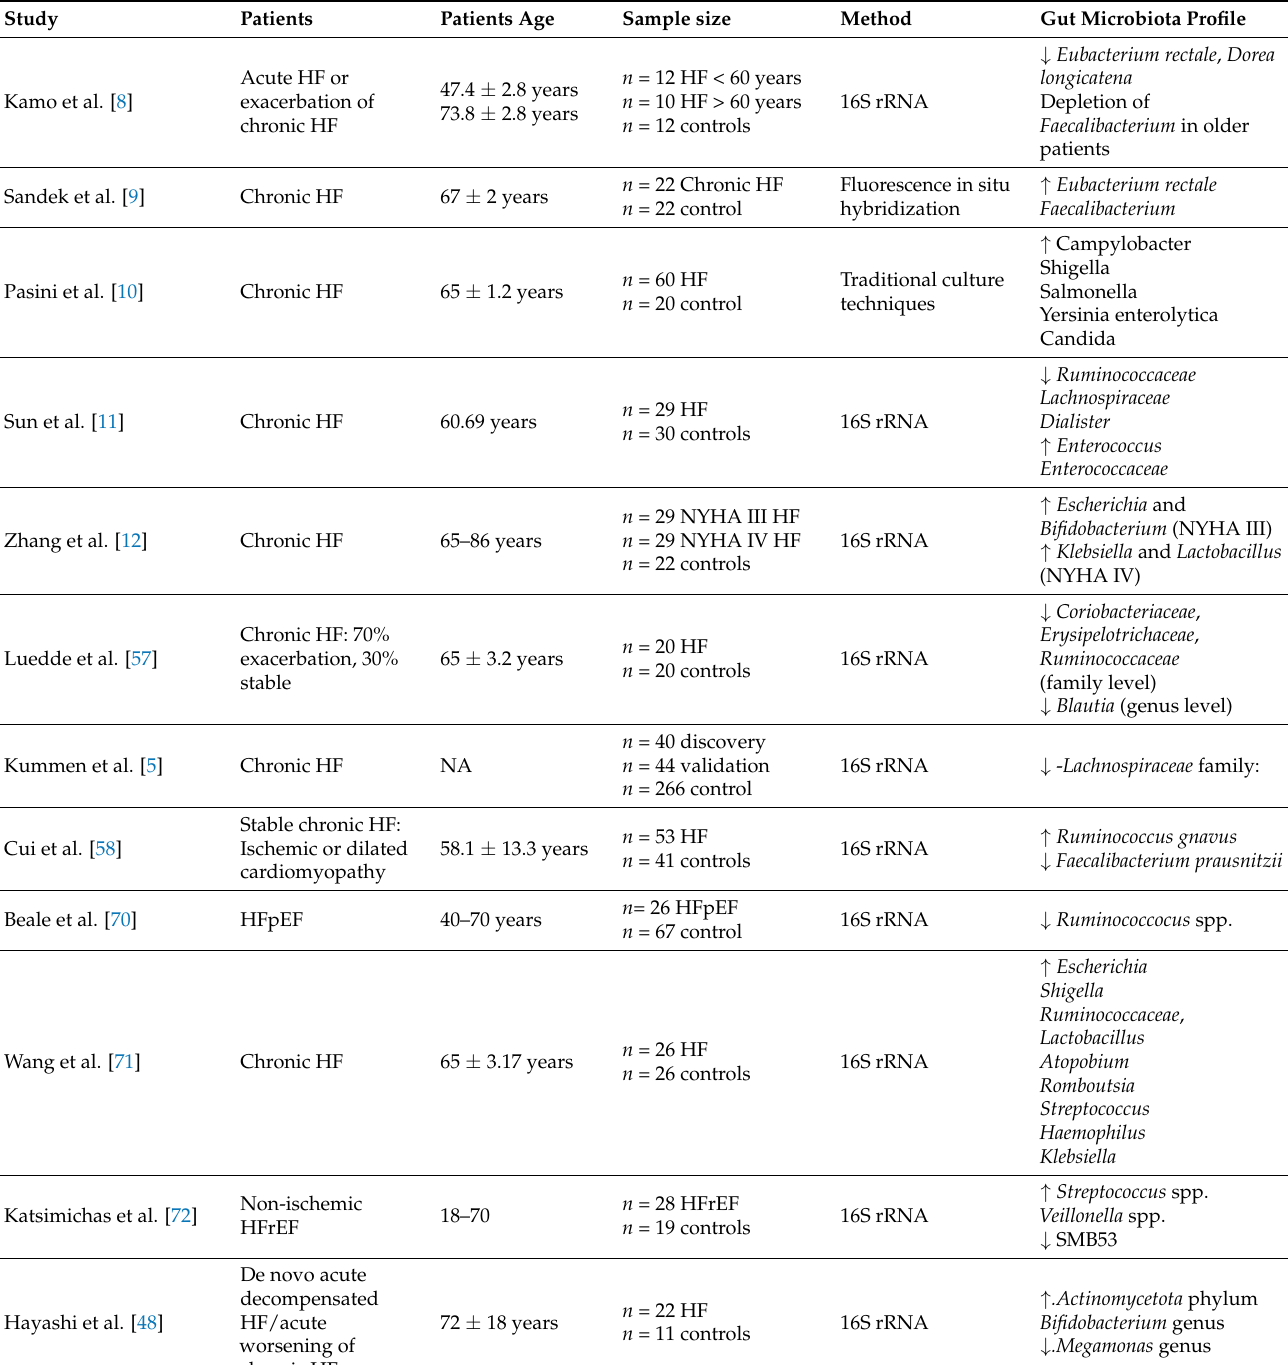
Table 2. Gut microbiota composition studies in patients with heart failure